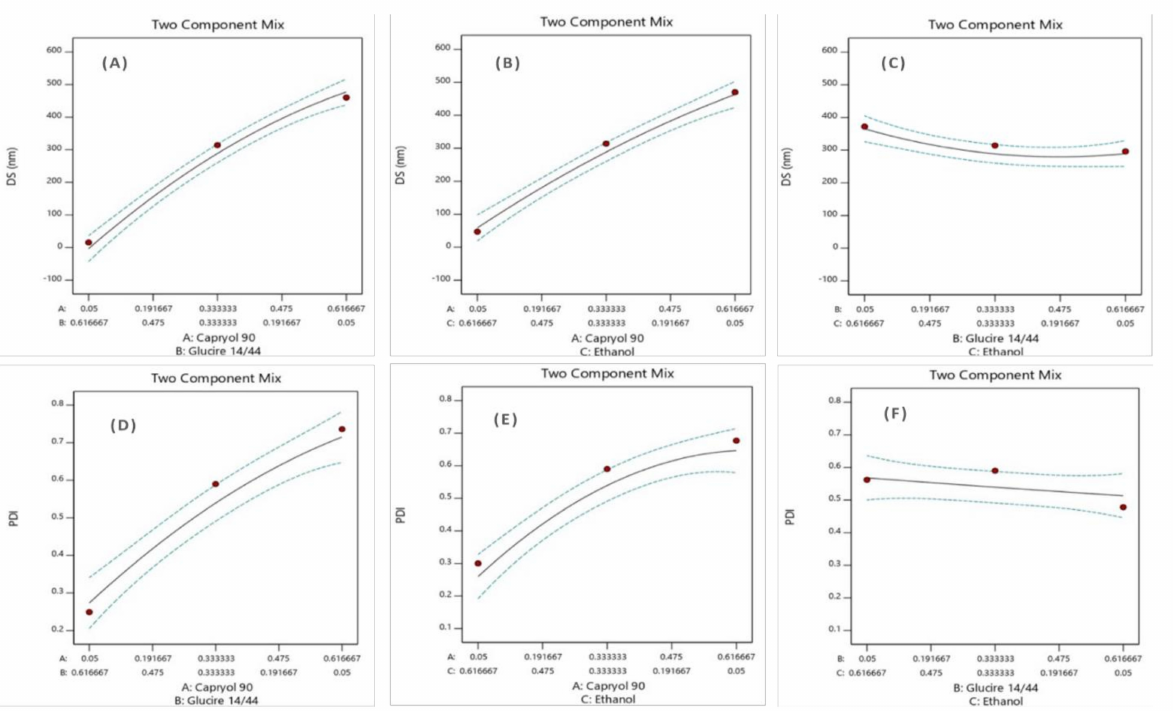
Figure 4. Factor effect plots showing the effect of two-component mix (Capryol TM 90/Gelucire ® 44/14, Capryol TM 90/Ethanol, and Gelucire ® 44/14/Ethanol): ( A – C ) on droplet size (DS) and ( D – F ) on poly dispersity index